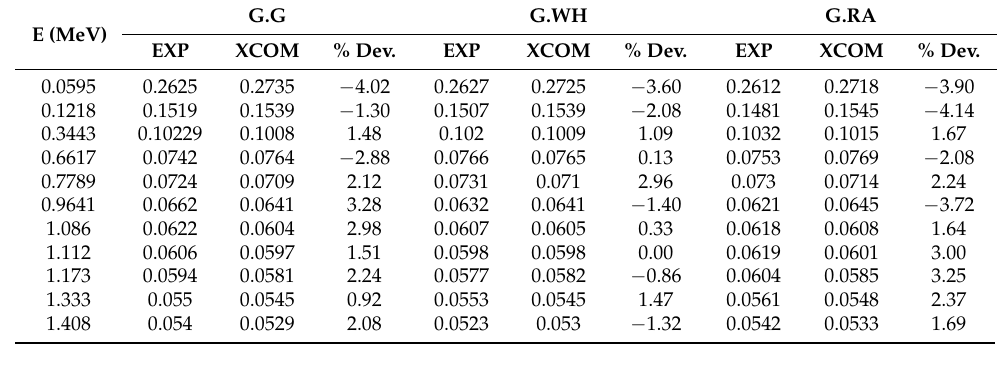
Table 3. Mass attenuation coefficient ( µ m ) for the granite sample.